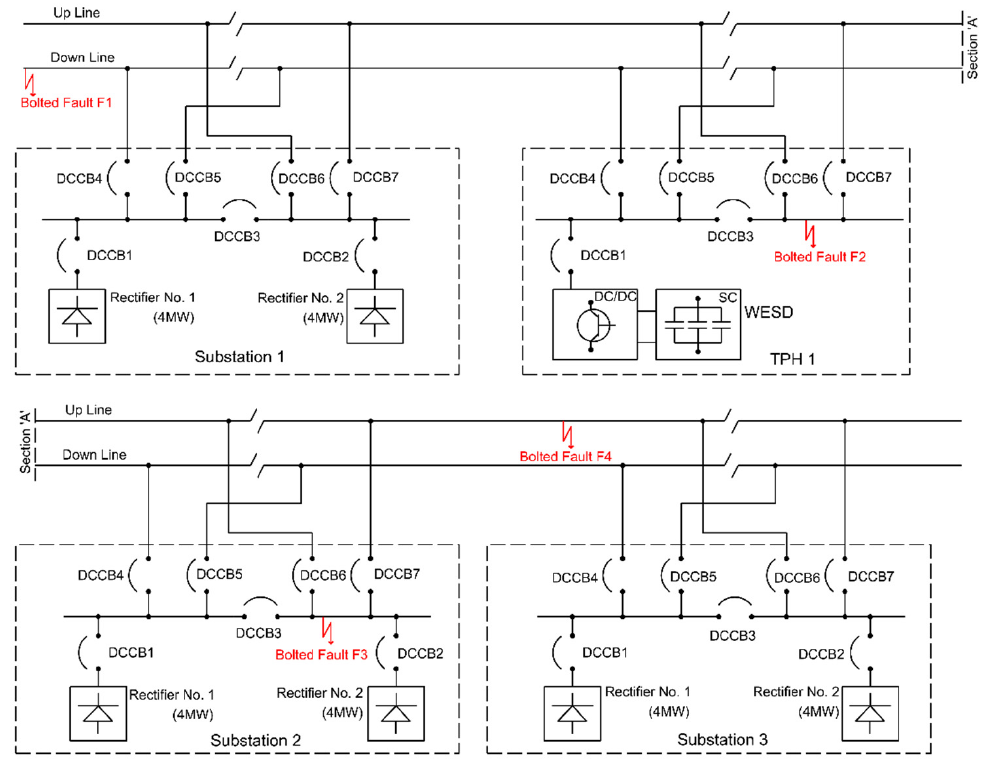
Figure 12. Fault scenarios modeled in MATLAB/Simulink.